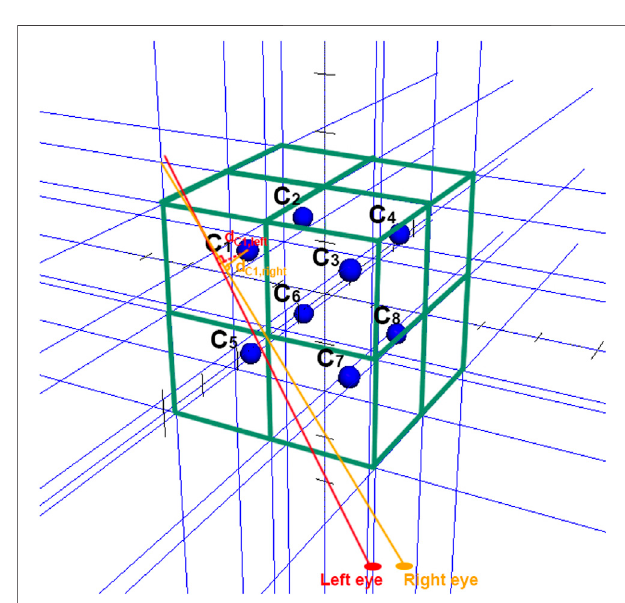
FIGURE 3 | Schematic of the space partition